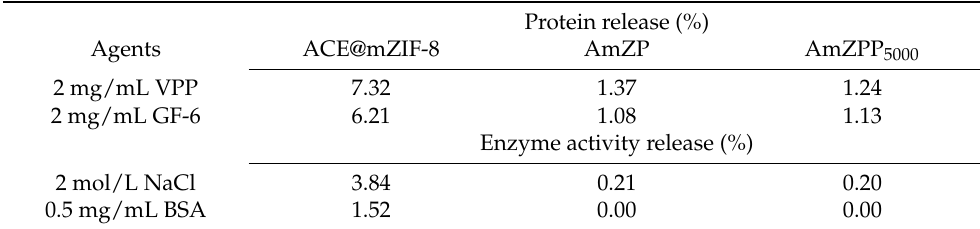
Figure 9. Desorption ( a , b ) and reusability ( c ) of AmZPP 5000. It has been reported that amino acids and protein could destroy the structure of ZIF- 8 because of the complexation of amino acids with zinc ions [54]. NaCl could also affect the structure of ZIF-8 [55]. As shown in Table 4, peptides NaCl and BSA could cause slight making AmZP and AmZPP5000 more stable. Table 4. Release of ACE from ACE@mZIF, AmZP and AmZPP 5000 after treatment with different agents for 1 h at 25 °C.